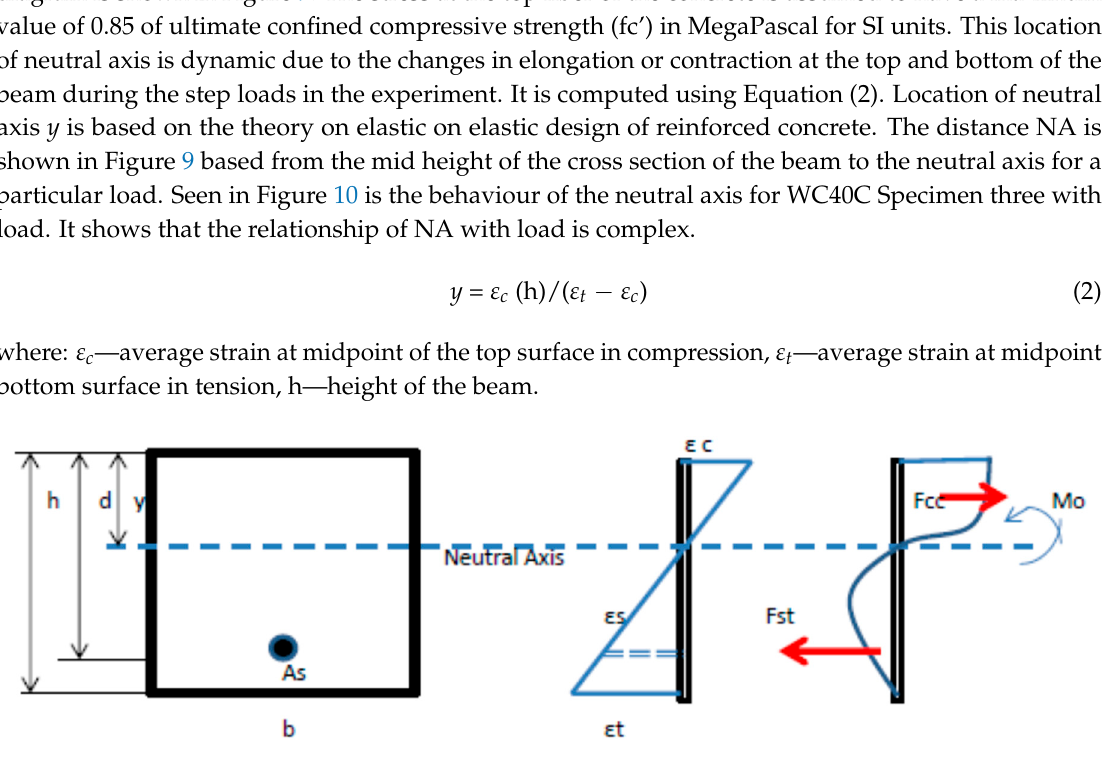
Figure 9. Neutral axis across ( A ) cross section of the beam; ( B ) strain diagram; ( C ) stress diagram. NA: neutral axis.